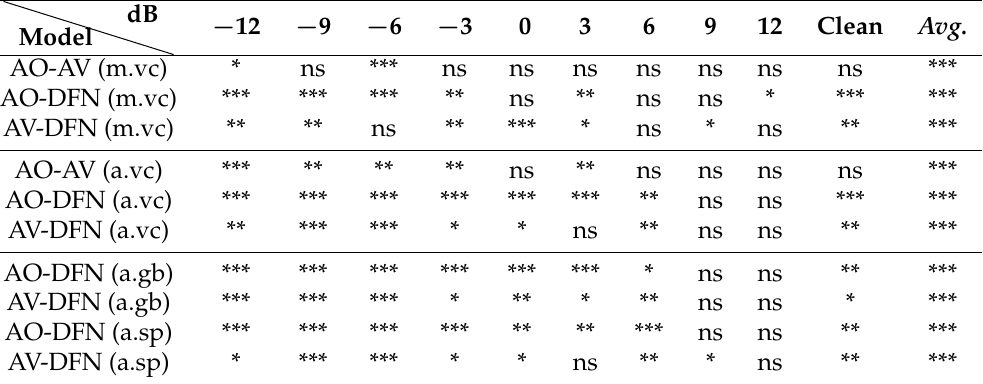
Table 9. Statistical significance tests, comparing the results of different model setups *** denotes p (cid:54) 0.001, ** shows 0.001 < p (cid:54) 0.01, * corresponds to 0.01 < p (cid:54) 0.05, and ns indicates results where p > 0.05; the other abbreviations are described in Table 8.